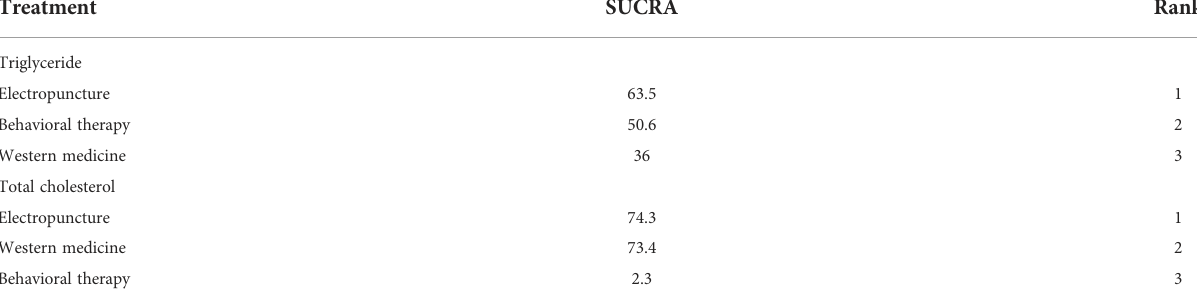
TABLE 10 Ef fi cacy ranking of mesh meta-analysis: triglyceride and total cholesterol. Treatment